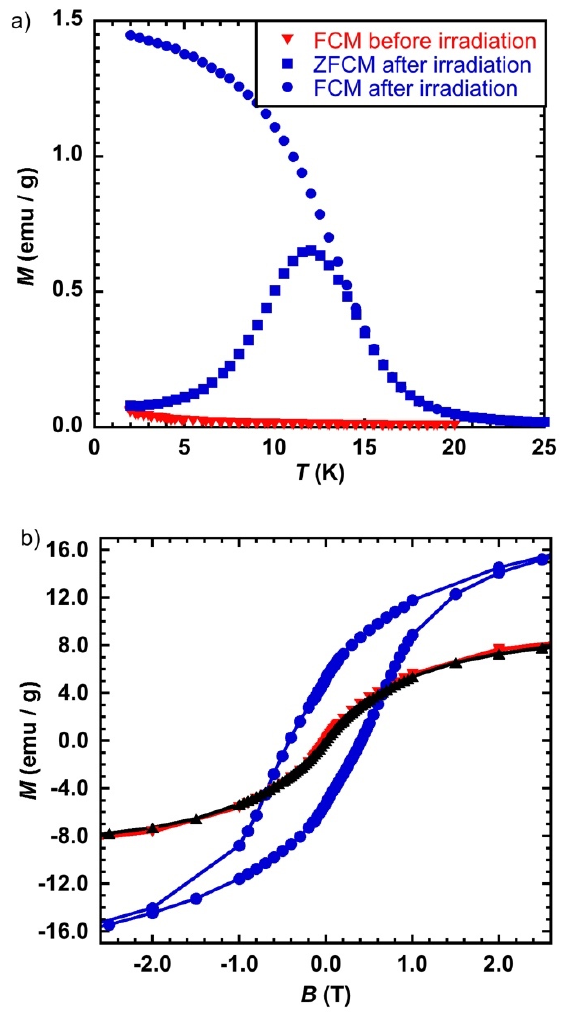
Figure 3. ( a ) M = f( T ) in the form of Field Cooled before ( (cid:72) ) and after ( • ) irradiation and Zero-Field Cooled after irradiation ( (cid:4) ) and ( b ) Magnetic hysteresis loop at T = 2 K before ( (cid:72) ) and after ( • ) irradiation and after relaxation ( (cid:78) ), for CsCoFe_CTA; laser power = 50 mW/cm 2 . The magnetic hysteresis loop measured before irradiation was characteristic of a paramagnetic behavior (Figure 3b), without an opening at zero field. After irradiation, a hysteresis loop appeared with a coercive field H C = 0.41 T, consistent with a relatively large magnetic anisotropy for the photoinduced state as expected from the presence of Co II within the nanoparticles [12]. In order to check the reversibility of the photoswitching, the sample was heated to T = 250 K (above its relaxation temperature) [8] and then